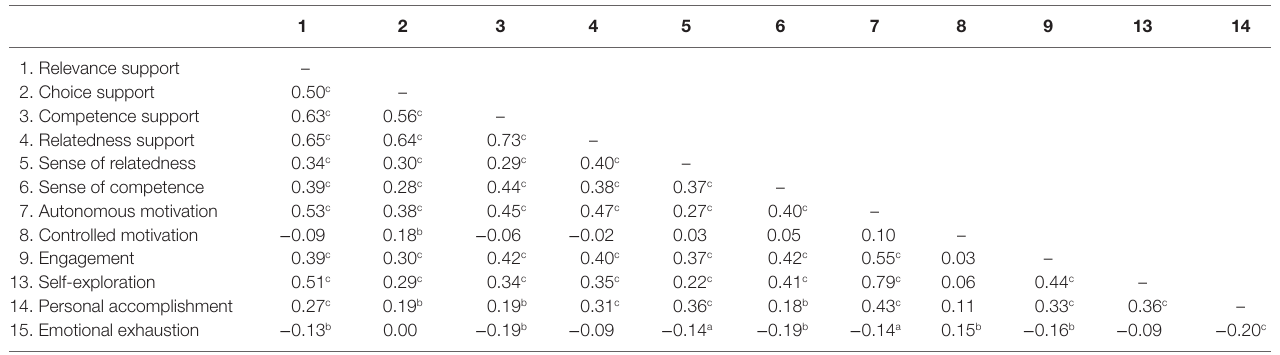
Table 2 | Correlation matrix of study